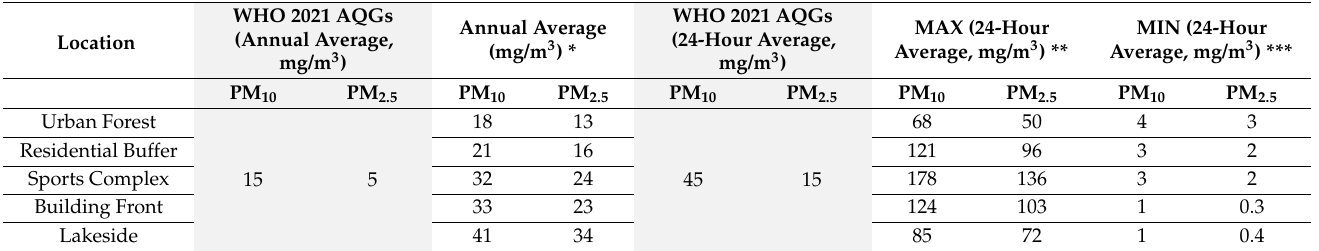
Table 3. Comparison of measured PM concentration values and WHO 2021 air quality guidelines (AQG, highlighted in